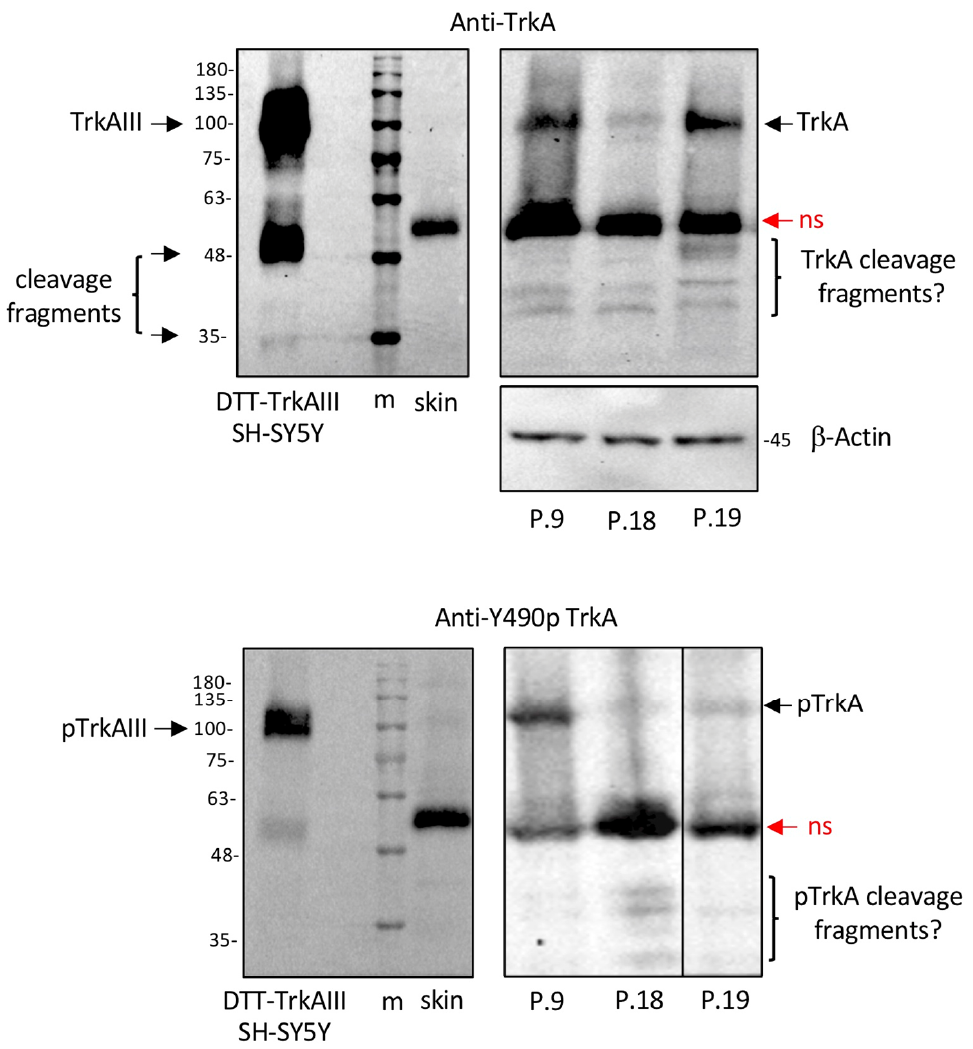
Figure 3. Metastatic CMMs express phosphorylated TrkA isoforms that resemble TrkAIII. Western blots demonstrating specific immunoreactive TrkA and phosphorylated TrkA species (pTrkAIII/pTrkA) (arrows) and non-specific species (ns), in stable TrkAIII SH-SY5Y transfectant extracts treated with DTT (5 mM for 6 h) (10 µ g), in a normal skin extract and in extracts from 3 metastatic CMMs (100 µ g). Potential TrkA and phosphorylated TrkA cleavage products are also indicated (cleavage fragments?).